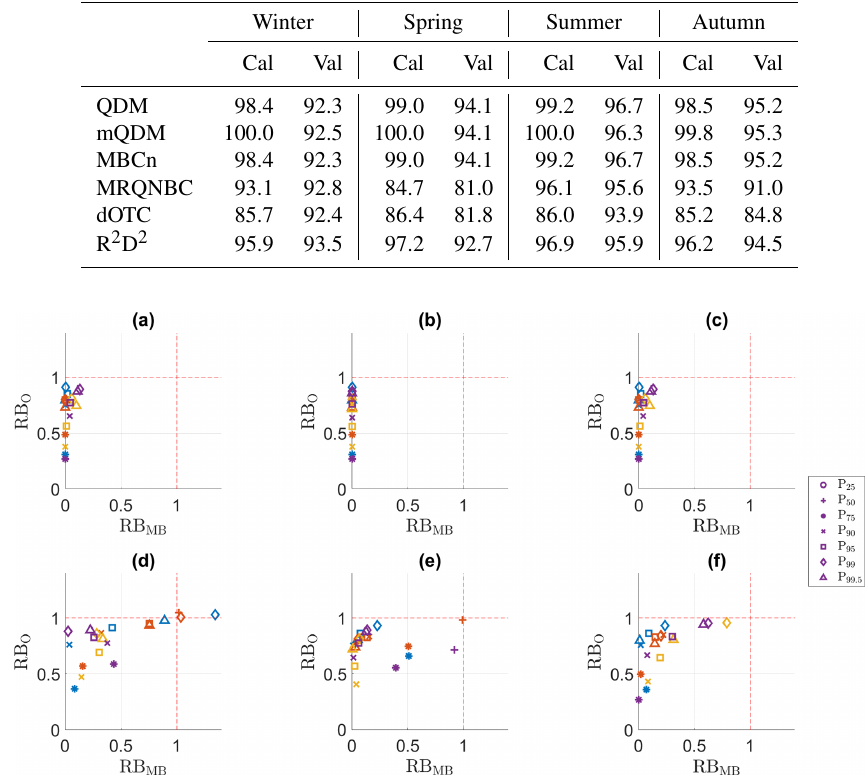
Table 5. PSS values for precipitation in the calibration (Cal) and validation (Val) periods (%). Winter Spring